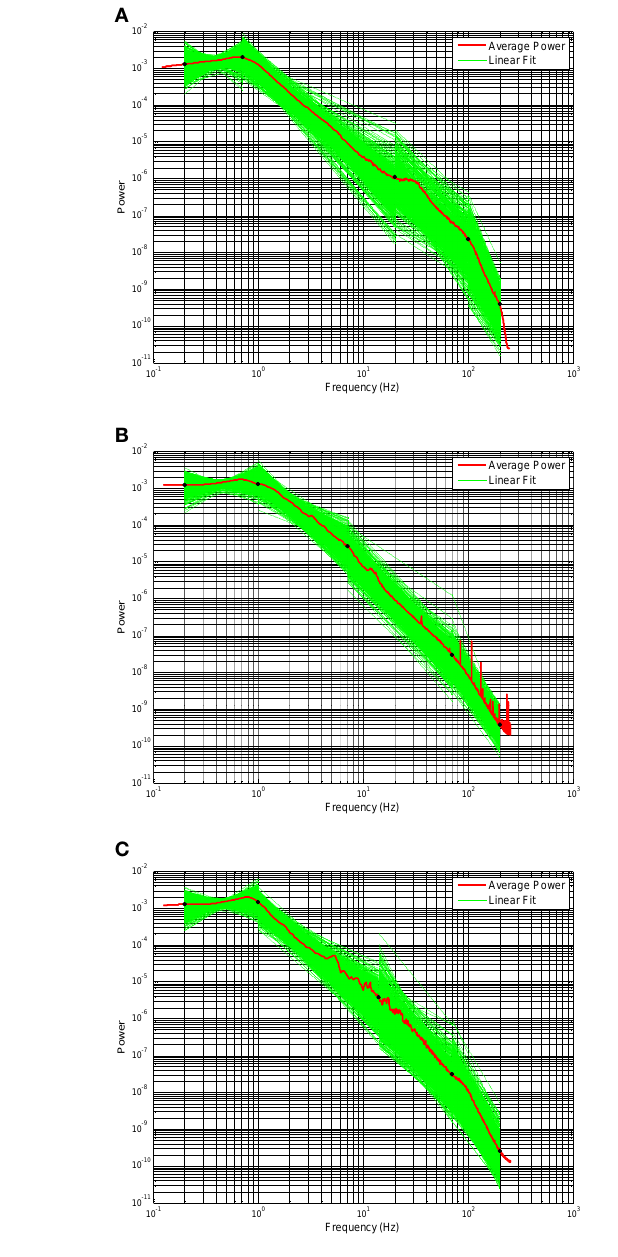
and awake (right column) states. The red (SWS) and blue (awake) lines are global averages of normalized power averaged across all electrodes and time intervals.